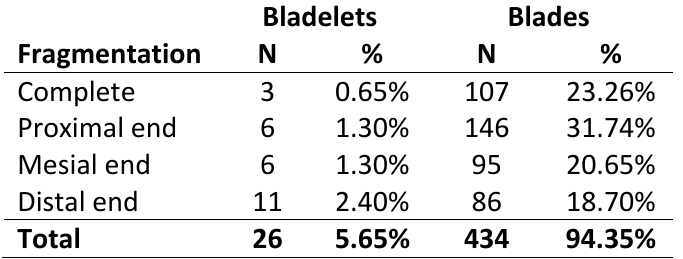
Table 2. Fragmentation pattern of the bladelets and blades